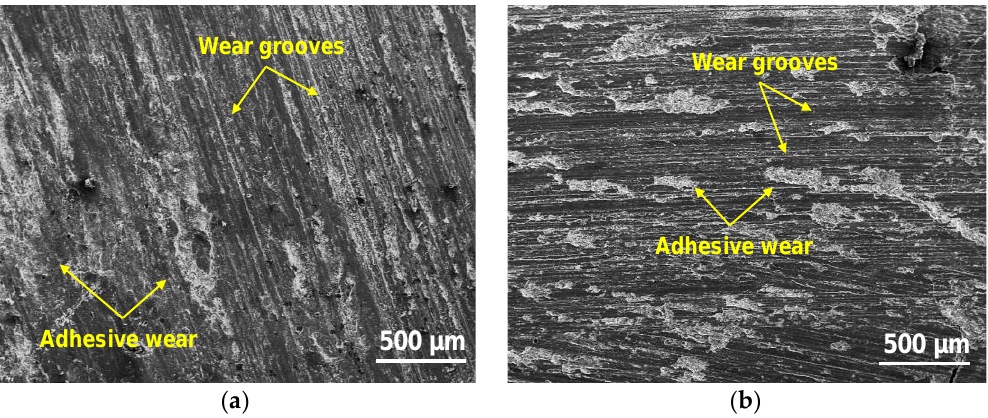
Figure 8. SEM micrograph of worn surface of C4 at: ( a ) initial design levels; ( b ) optimal design levels. Figure 9 and Figure 10 show the elemental mapping obtained by EDAX analysis of interface.